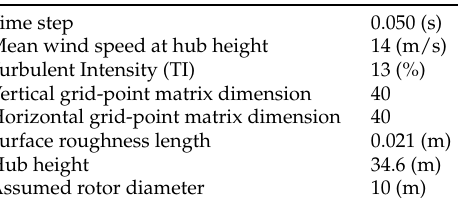
Table 2. Wind field simulation parameters.